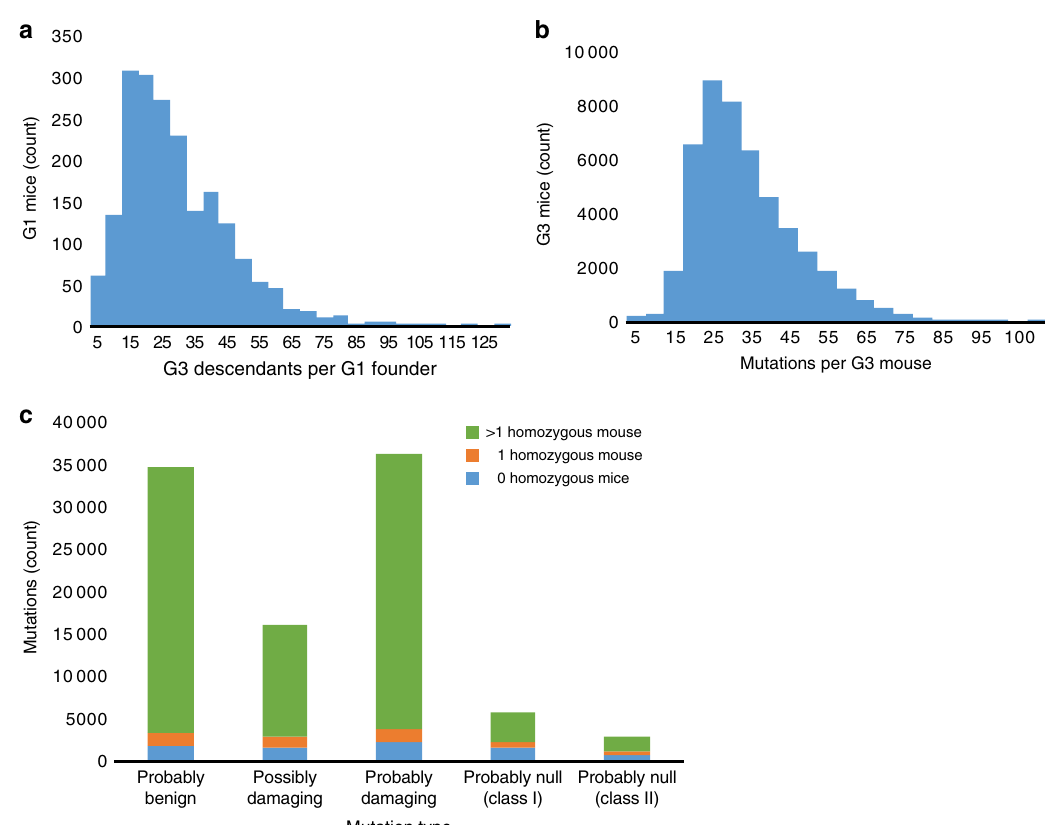
Fig. 1 Characteristics of mice and mutations analyzed. a Number of G3 mice descended from the G1 male founder of each pedigree. b Number of heterozygous or homozygous exomic mutations in each G3 mouse. c Number of mutations of each mutation classi fi cation bred to homozygosity in 0, 1, or > 1 mouse. Mutations were non-synonymous coding and potential splicing changes ( b , c )